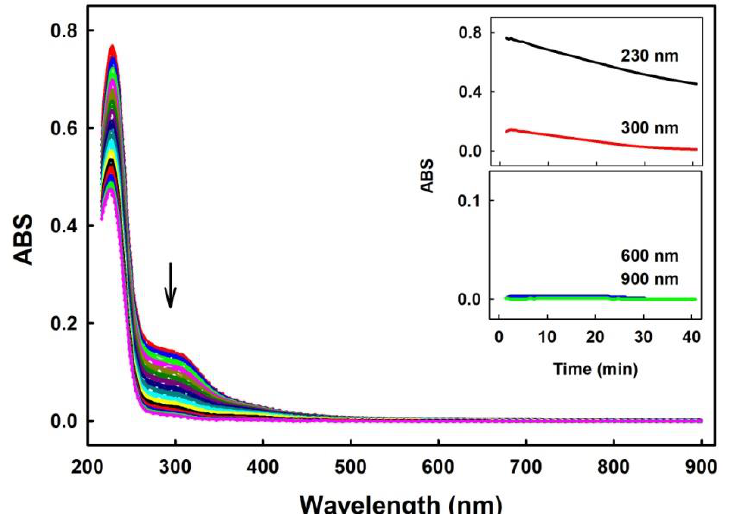
Figure 1. Representative time-dependent UV-VIS spectra of 100 µM Na 2 S 2 in 100 mM sodium phosphate, 100 µM diethylenetriaminepentaacetic acid (DTPA), pH 7.4, at 37°C. Spectra were recorded every 30 s for 40 min. The first spectrum was recorded 15 s after thawing of 10 mM Na 2 S 2 stock. Arrow indicates decrease of ABS at 280 and 300 nm. The first spectrum is indicated by the solid red line, which is followed each 30 s by long dash red, medium dash red, short dash red, dotted red, full blue line, long dash blue, medium dash blue, etc. Insets: Kinetics of changes in ABS at 230 nm (black), 300 nm (red), 600 nm (blue) and 900 nm (green).